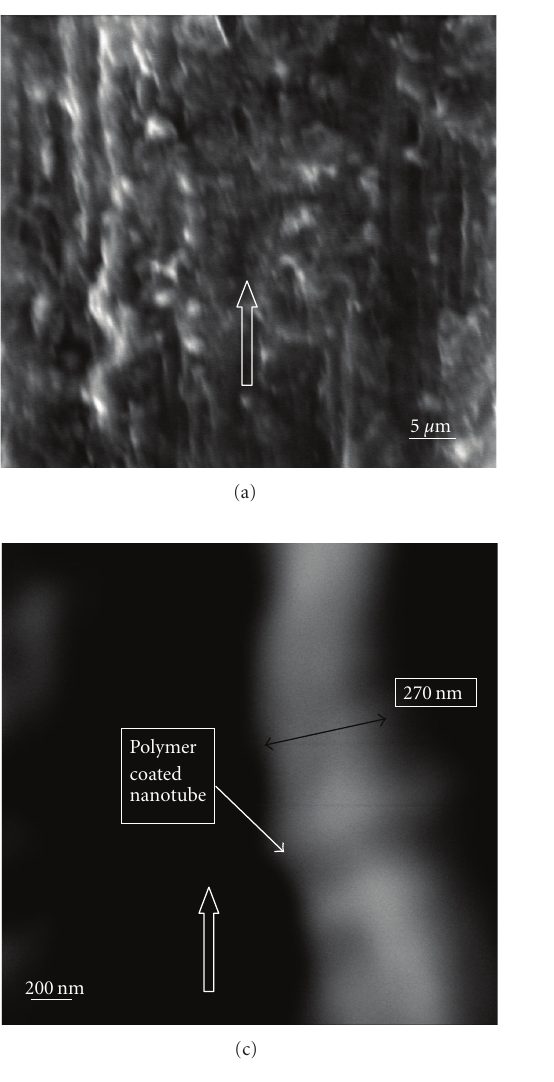
Figure 6: SEM micrographs of (a) neat UHMWPE, (b) strain hardened UHMWPE, (c) UHMWPE-MWCNT, and (d) strain hardened UHMWPE-MWCNT.